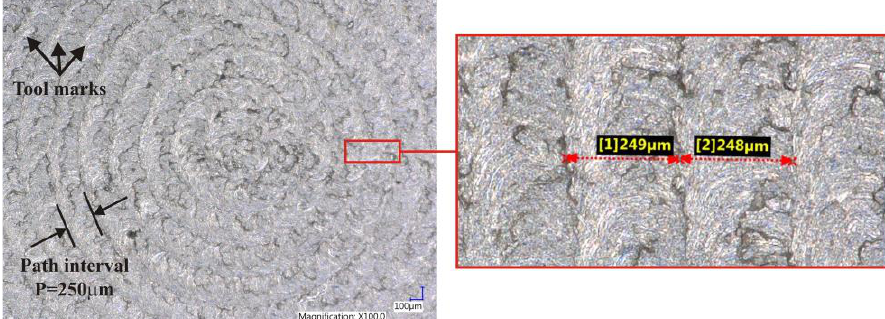
Figure 29. Tool marks and measured path interval in THE constant step over-pocket auto border STRATEGY.